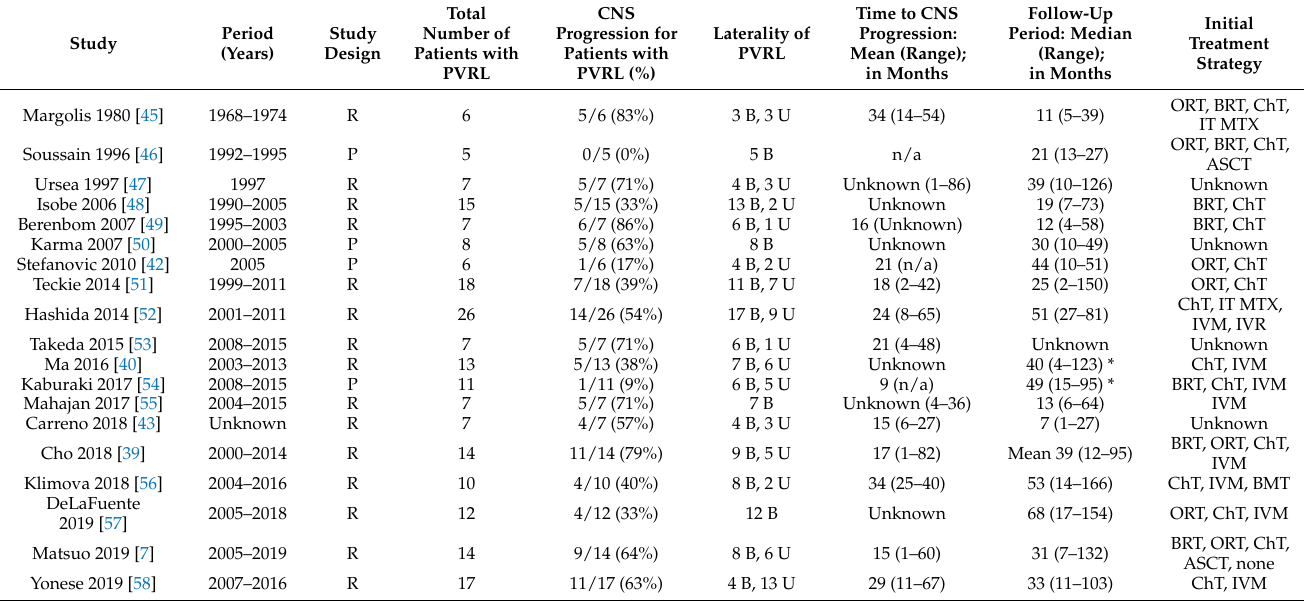
Figure 1. Flowchart illustrating study selection based on the PRISMA model. Table 1. Study characteristics.